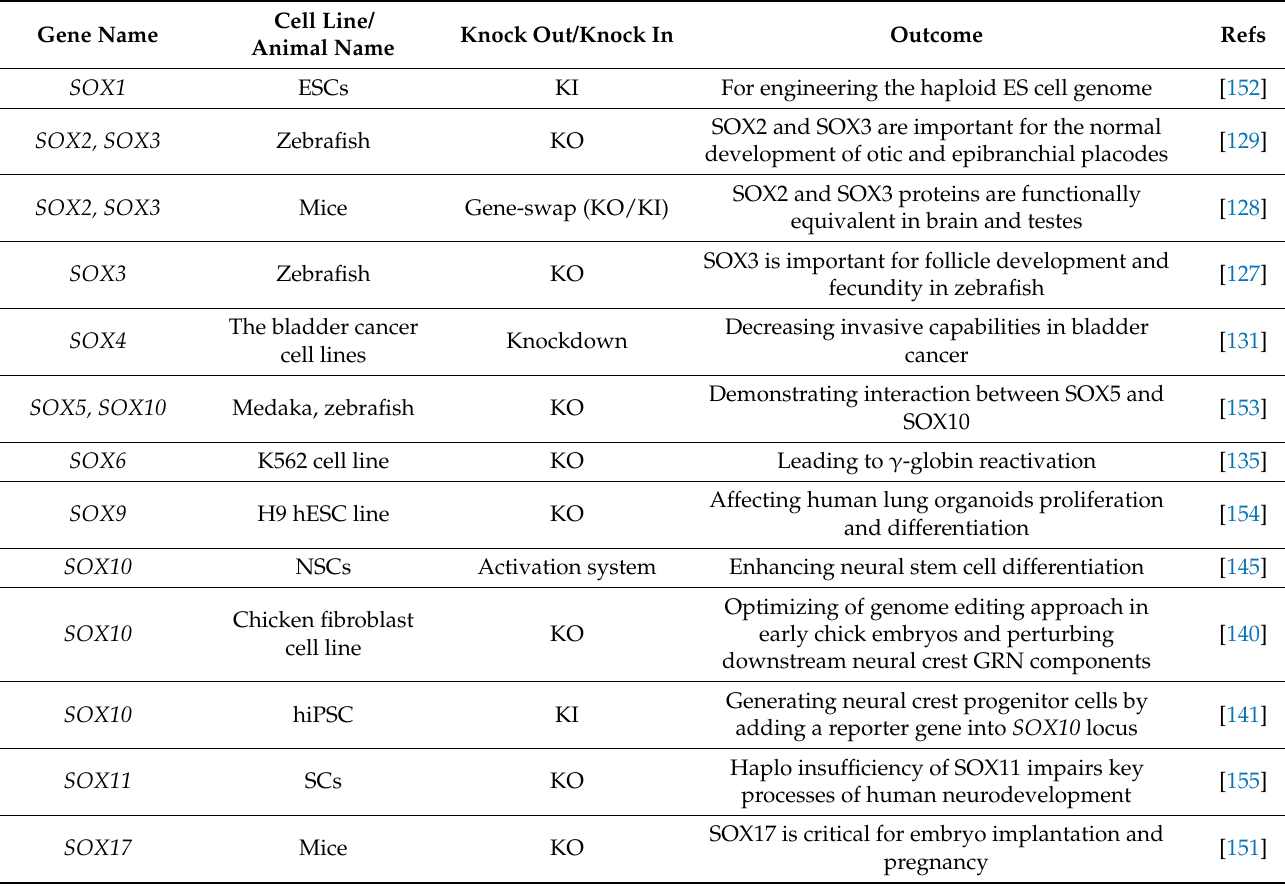
Table 2. CRISPR targeting other SOX